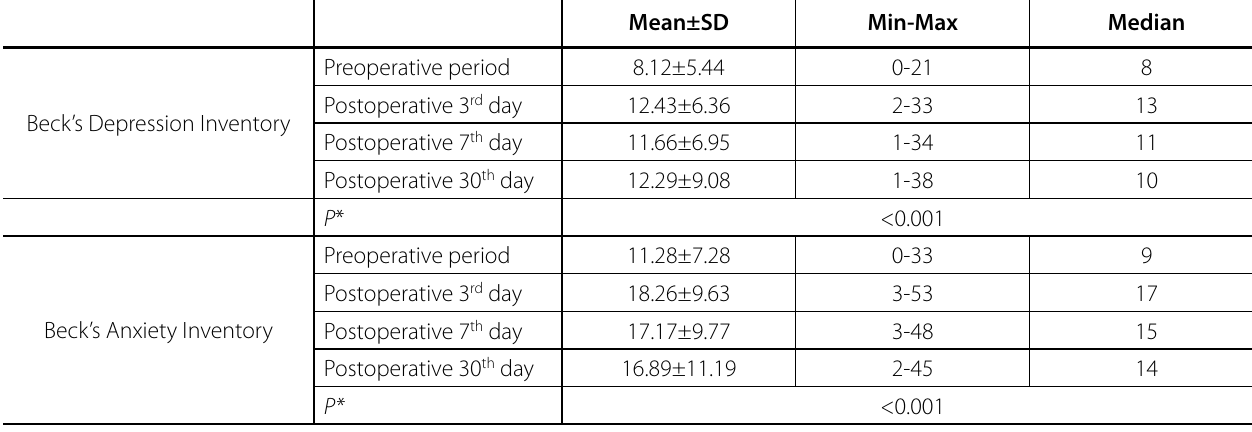
Table 2 . Statistical analysis of the anxiety and depression levels. Beck’s depression and anxiety scores increased significantly in the postoperative period compared to the preoperative